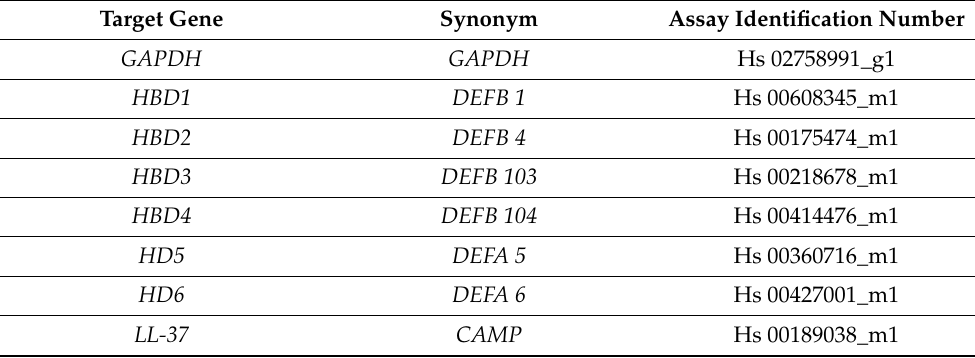
Table 1. Gene expression